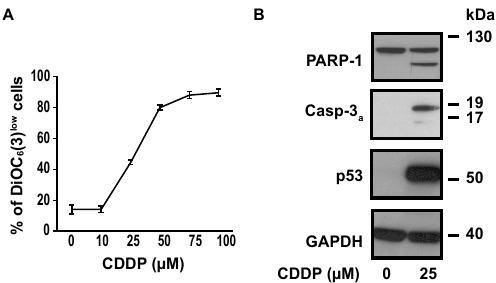
Figure 1. Dose-response relationship in CDDP-treated A549 cells. ( A ) Cytofluorometric assessment of ΔΨ m (with the ΔΨ m -sensitive probe DiOC 6 (3)) after 24 h treatment with CDDP at indicated concentrations. ( B ) Immunoblot analysis showing the effect of 24 h treatment with 25 µM CDDP on PARP-1 cleavage, caspase-3 cleavage and p53 accumulation. GAPDH is used as a loading control. Depletion of STIM1 with a pool of four different siRNAs (named siSTIM1) reduced CDDP- induced ΔΨ m dissipation and plasma membrane permeabilization (measured by the vital dye propidium iodide, PI) (Figure 2A,B). We previously showed that the cation channel TRPC1 mediated SOCE in A549 cells [27]. In this study, we observed that siRNA-mediated depletion of TRPC1 decreased CDDP-induced apoptosis in a similar level to STIM1 depletion (Figure 2A,B).